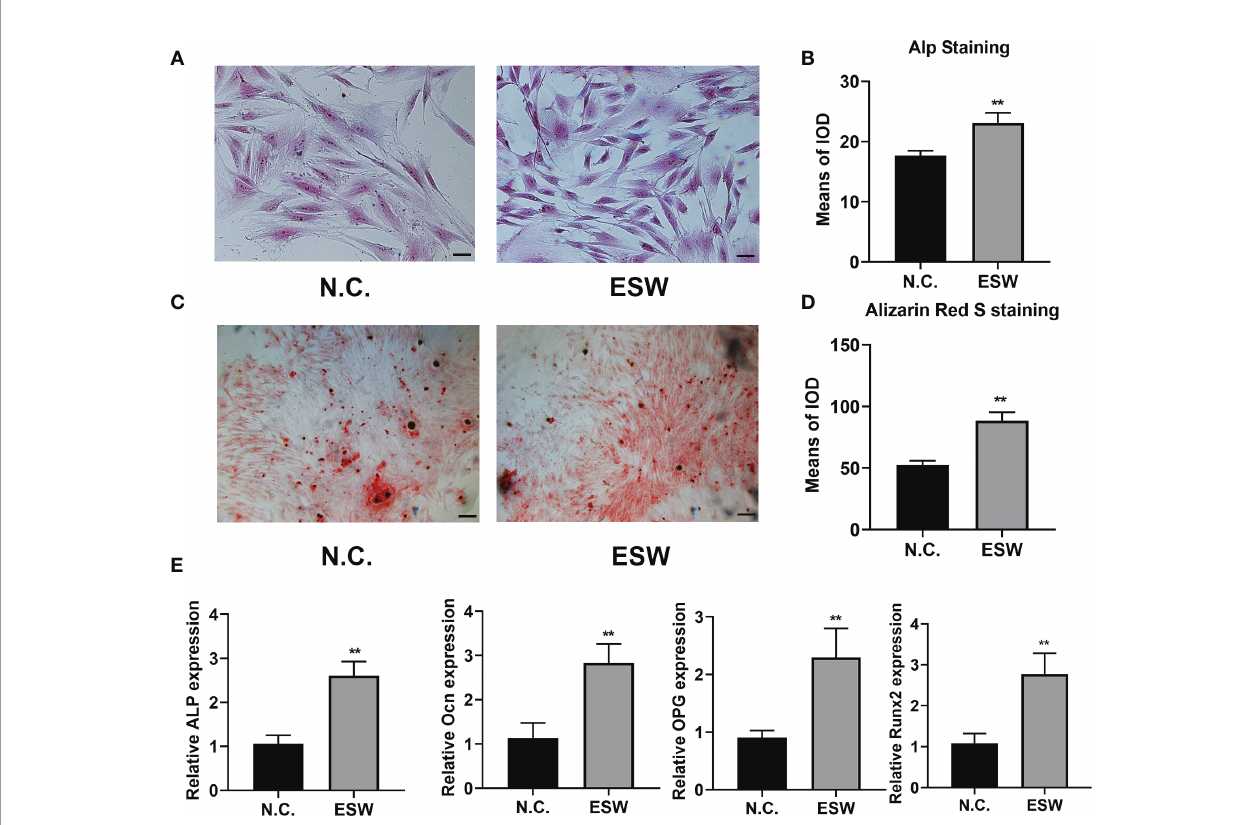
FIGURE 1 | ESW therapy promoted osteoblast differentiation in vitro . (A) The ALP staining of BMSCs cultured in DMEM treated with N.C. or ESW, and quantitative analysis, Scale bar: 100 m m (B) ; (C) The Alizarin Red S staining of BMSCs cultured in DMEM treated with N.C. or ESW, and quantitative analysis, Scale bar: 100 m m (D); (E) The mRNA expression of ALP, OCN, OPG, and RUNX2 of BMSCs cultured in a-MEM treated with N.C. or ESW after 24 h. Data are reported as the mean ± SD. **p <